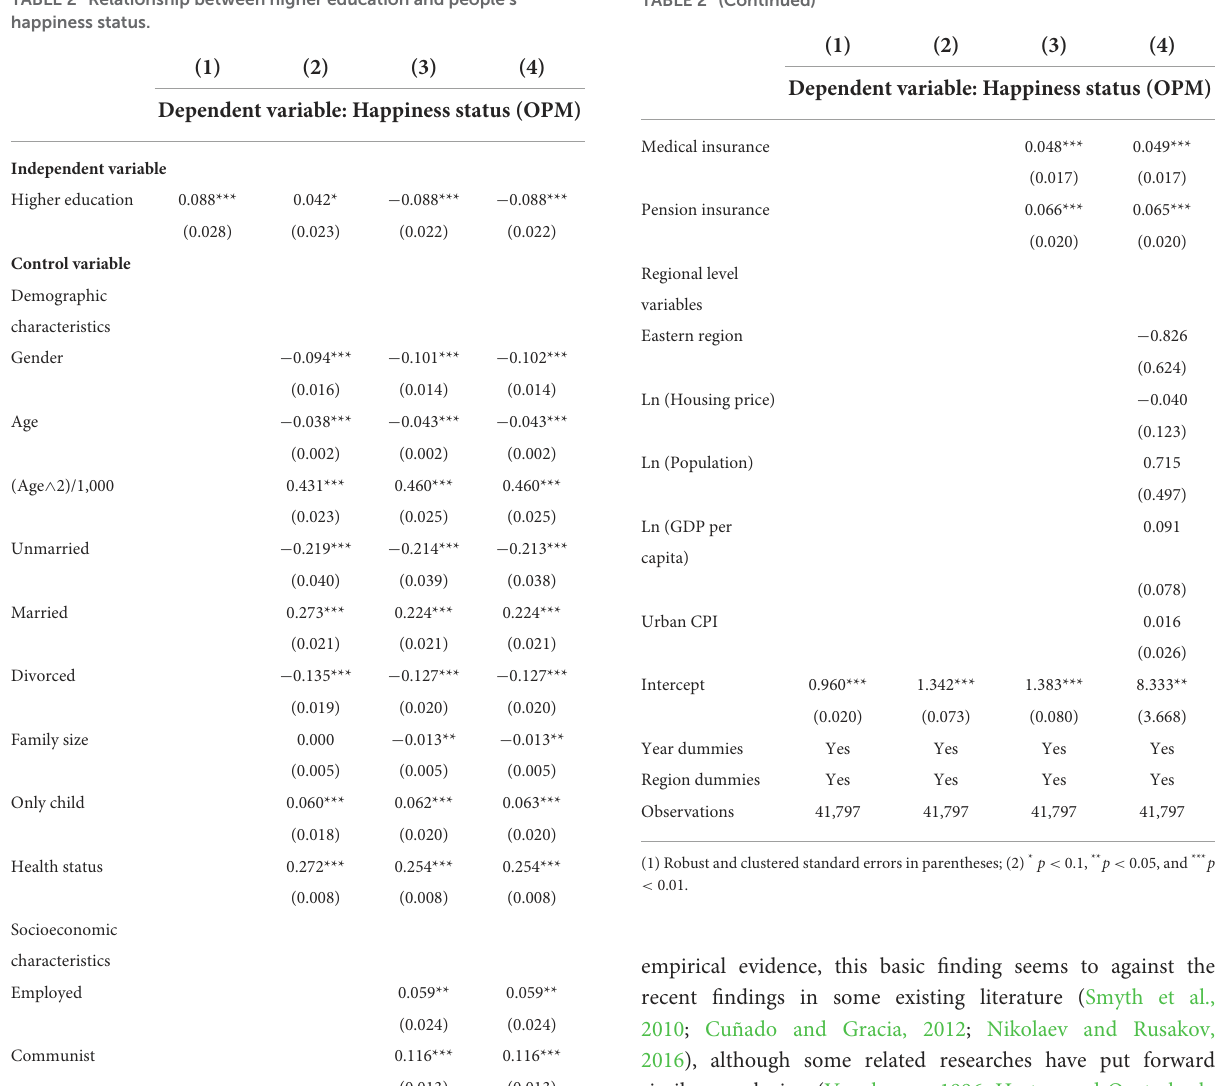
TABLE 2 Relationship between higher education and people’s happiness